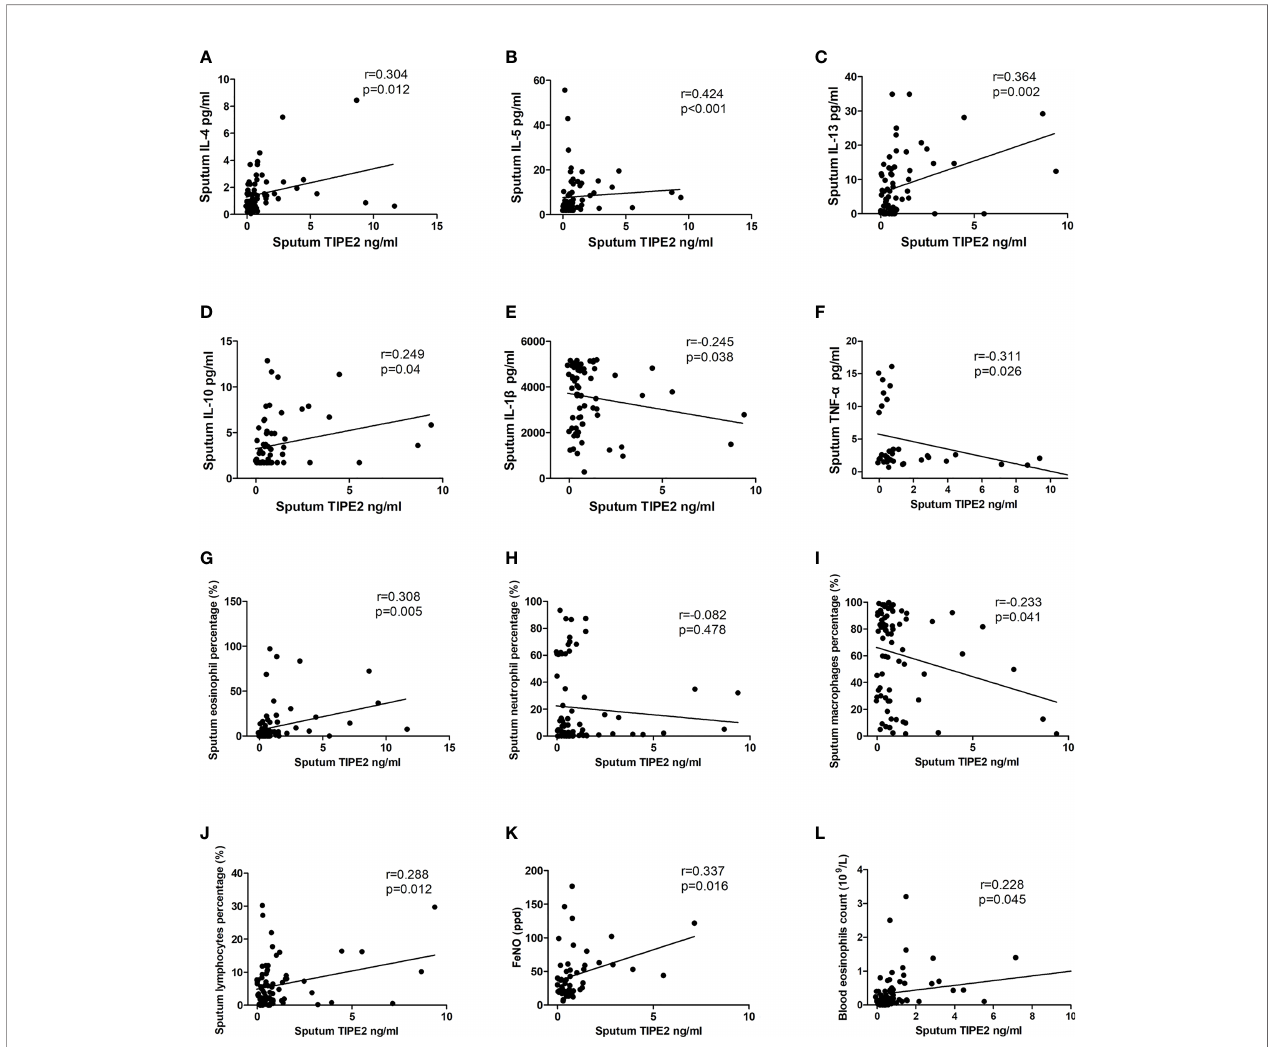
FIGURE 2 | Correlations between TIPE2 and in fl ammatory mediators/clinical characteristics. TNFAIP8, tumor necrosis factor-alpha-induced protein – 8; TIPE, TNFAIP8-like; IL, interleukin; TNF- a , tumor necrosis factor- a ; FeNO, fractional exhaled nitric